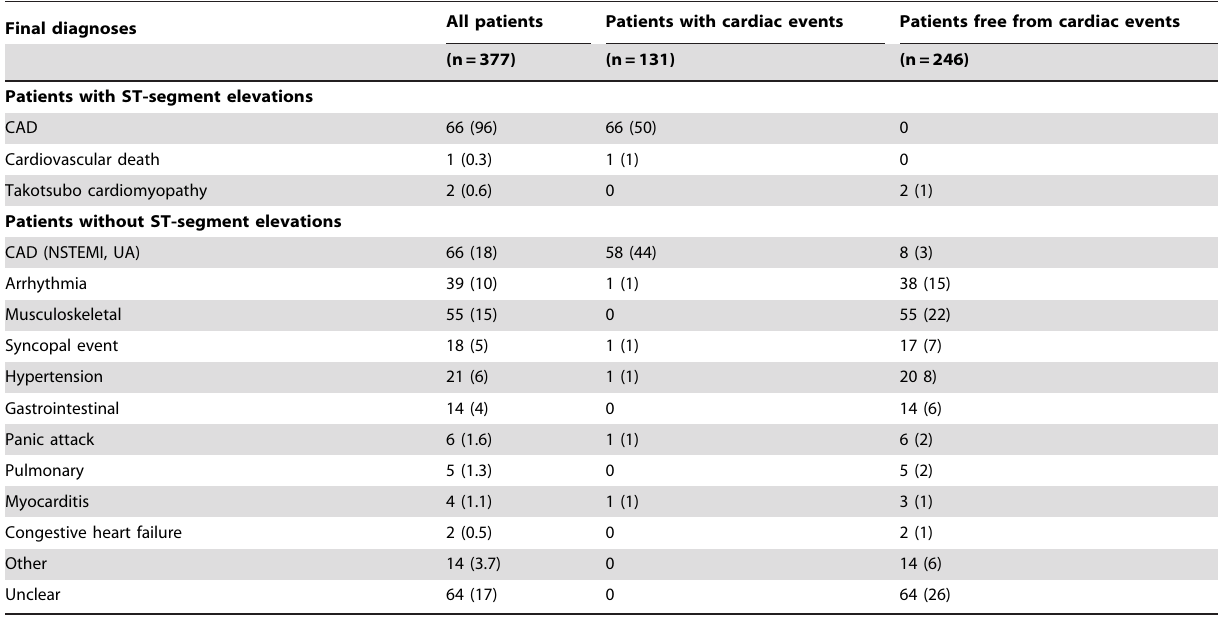
Table 2. Final diagnoses.